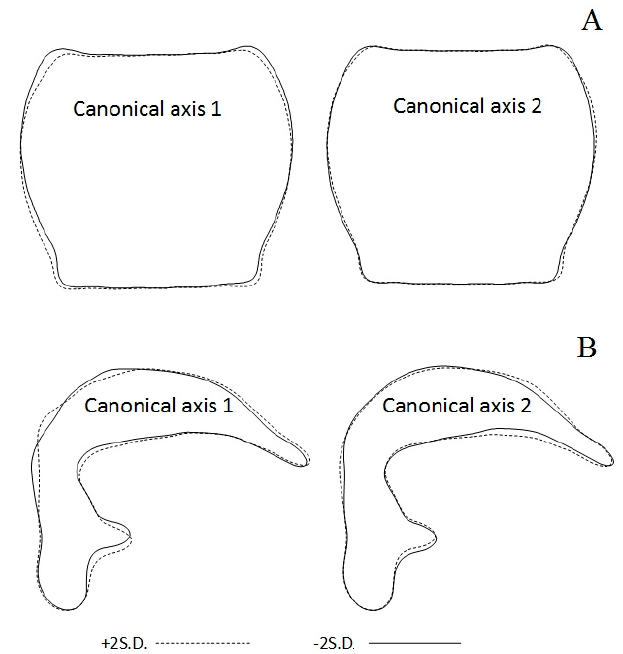
Figure 5. Pronotum ( A ) and aedeagus ( B ) shape variations of Pterostichus brevicornis brevicornis . Outlines were reconstructed, and the principal component scores with standard deviation values (±2 SD) were represented for the first two canonical axes (for details see Table 4).